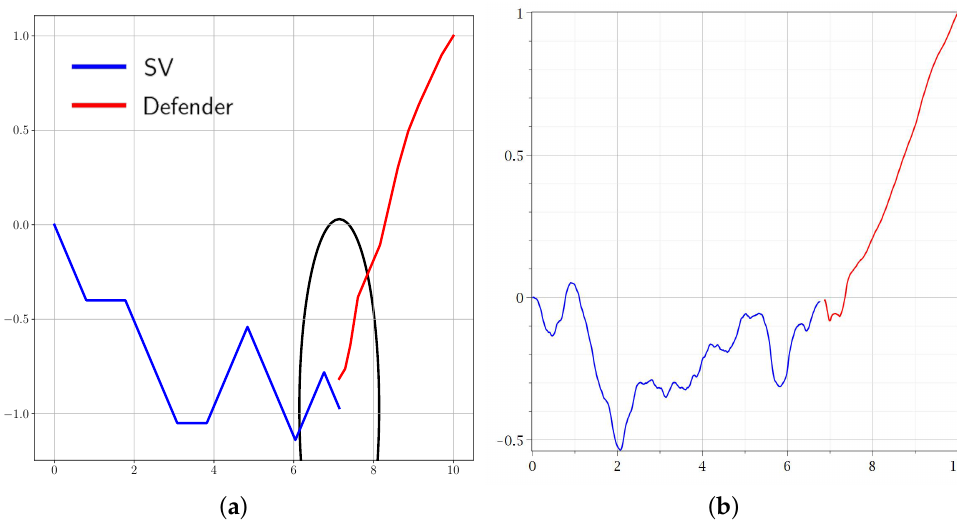
Figure 6. Intrusion of the SV’s detection zone. ( a ) SV and defender trajectories corresponding to the path of θ t ; ( b ) SV and defender trajectories corresponding to the path of Θ t